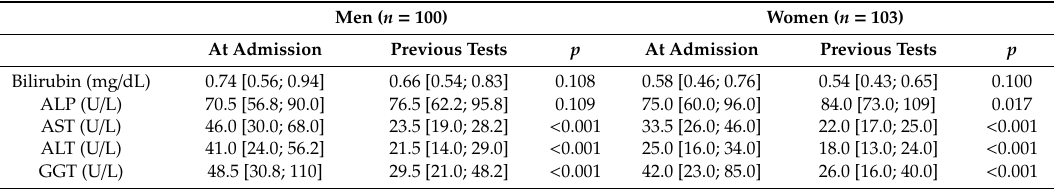
Table 3. Liver tests before and after COVID-19 infection by